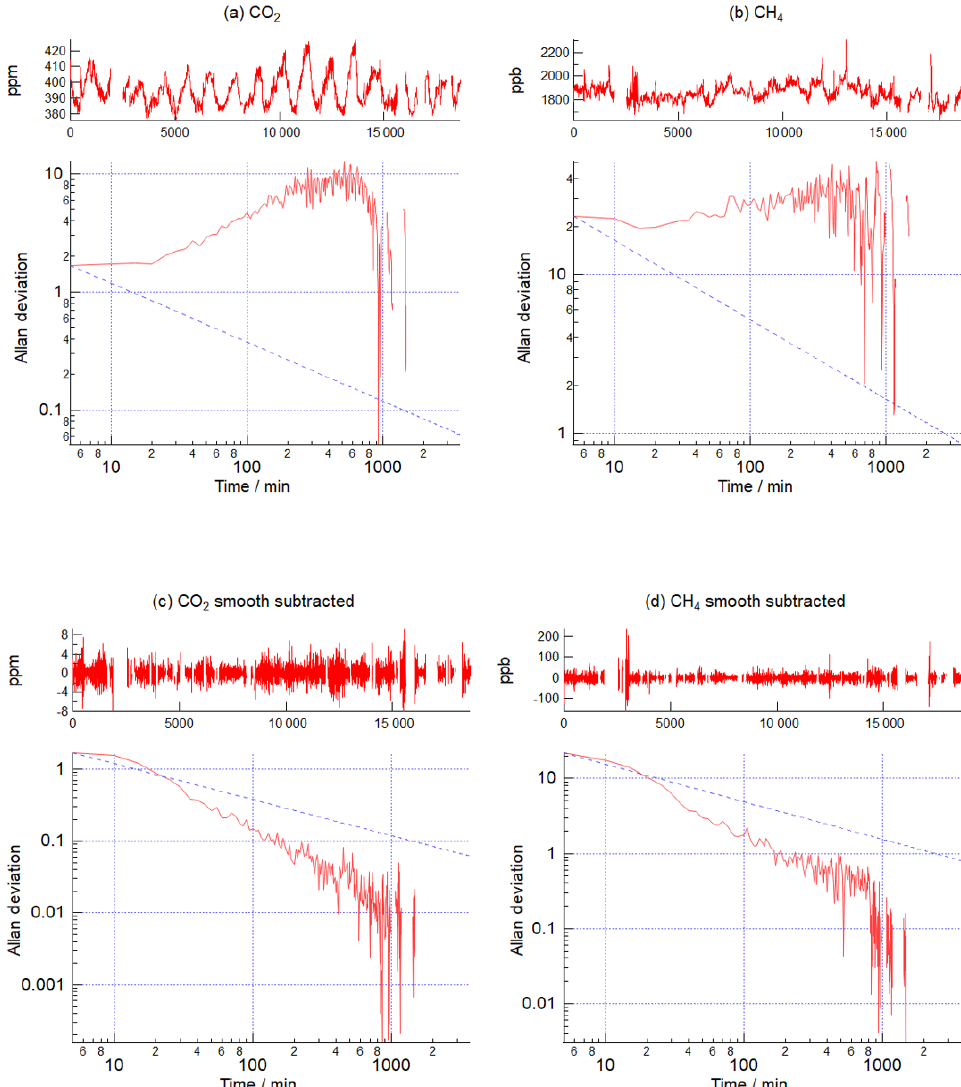
Figure 13. Allan deviation plots for (a) OP CO 2 , (b) OP CH 4 , (c) smooth-subtracted OP CO 2 and (d) smooth-subtracted OP CH 4 . See text for details of subtraction of smoothed from raw time